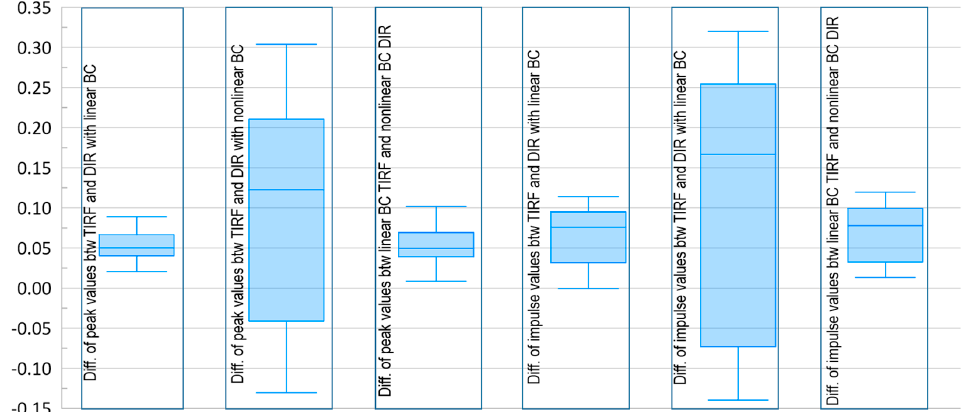
Figure 16. Box and whisker plots for the difference in the peak bending stresses and impulse values using TIRF and DIR. Table 8. Dimension of the LNG carrier hull structure for Model 3.